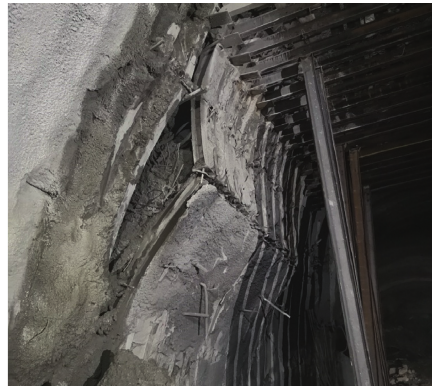
Figure 16: Large settlement and convergence at left arch foot of the upper